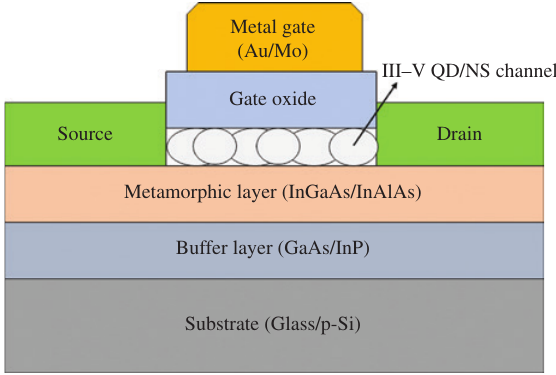
Figure 7: Proposed schematic of III–V QD or nanostructured (NS) channel based MOSFET.